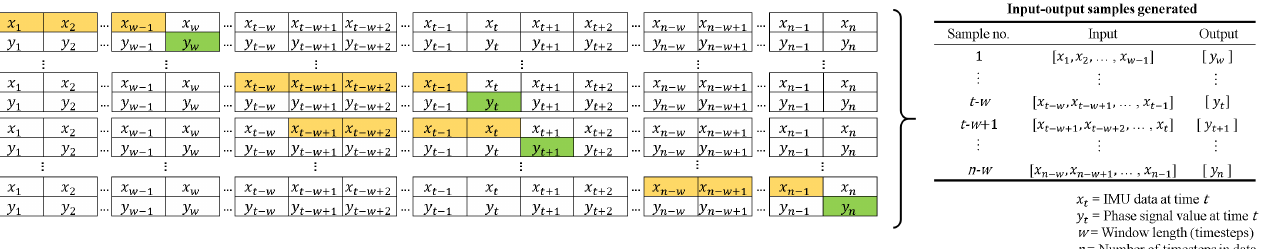
Figure 3. The training data is prepared as input–output pairs where the input consist of previous values (yellow) of the pelvis IMU signals in a moving window and the output is the next value (green) of groundtruth phase signal after the